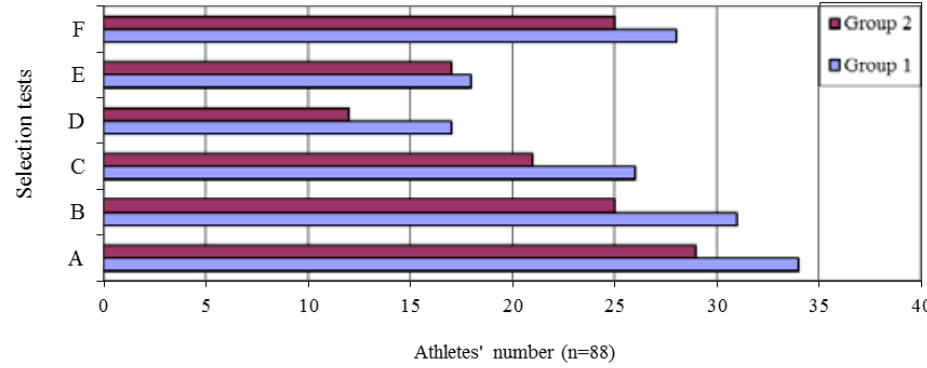
Fig. 3. Data on the number of athletes who have successfully passed the